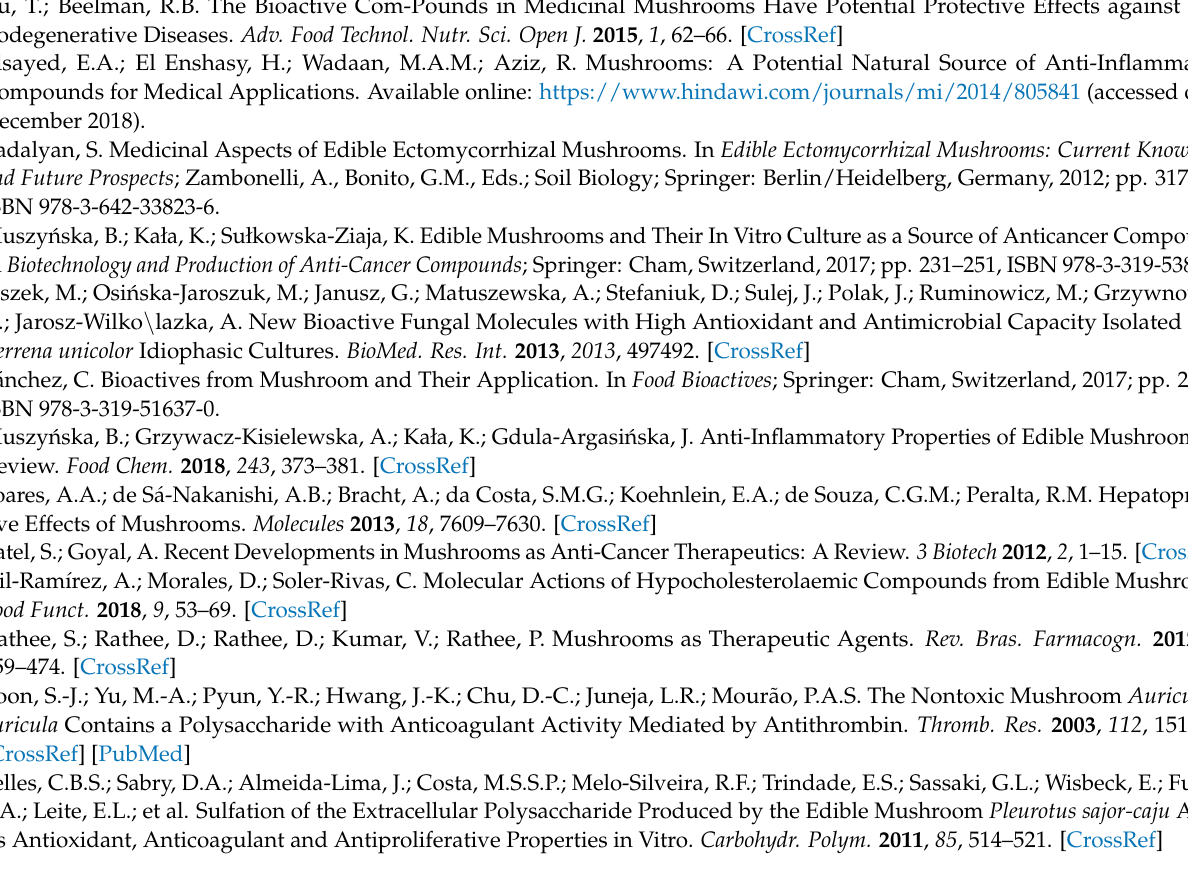
human plasma (A), clotting time (B), and clot formation rate (C) expressed as percentage of control was determined. Figure S2: Effect of the human fibrinogen on normal CCD 841 CoTr and cancer HT-29 cell (A) viability (NR method) and (B) proliferation (MTT